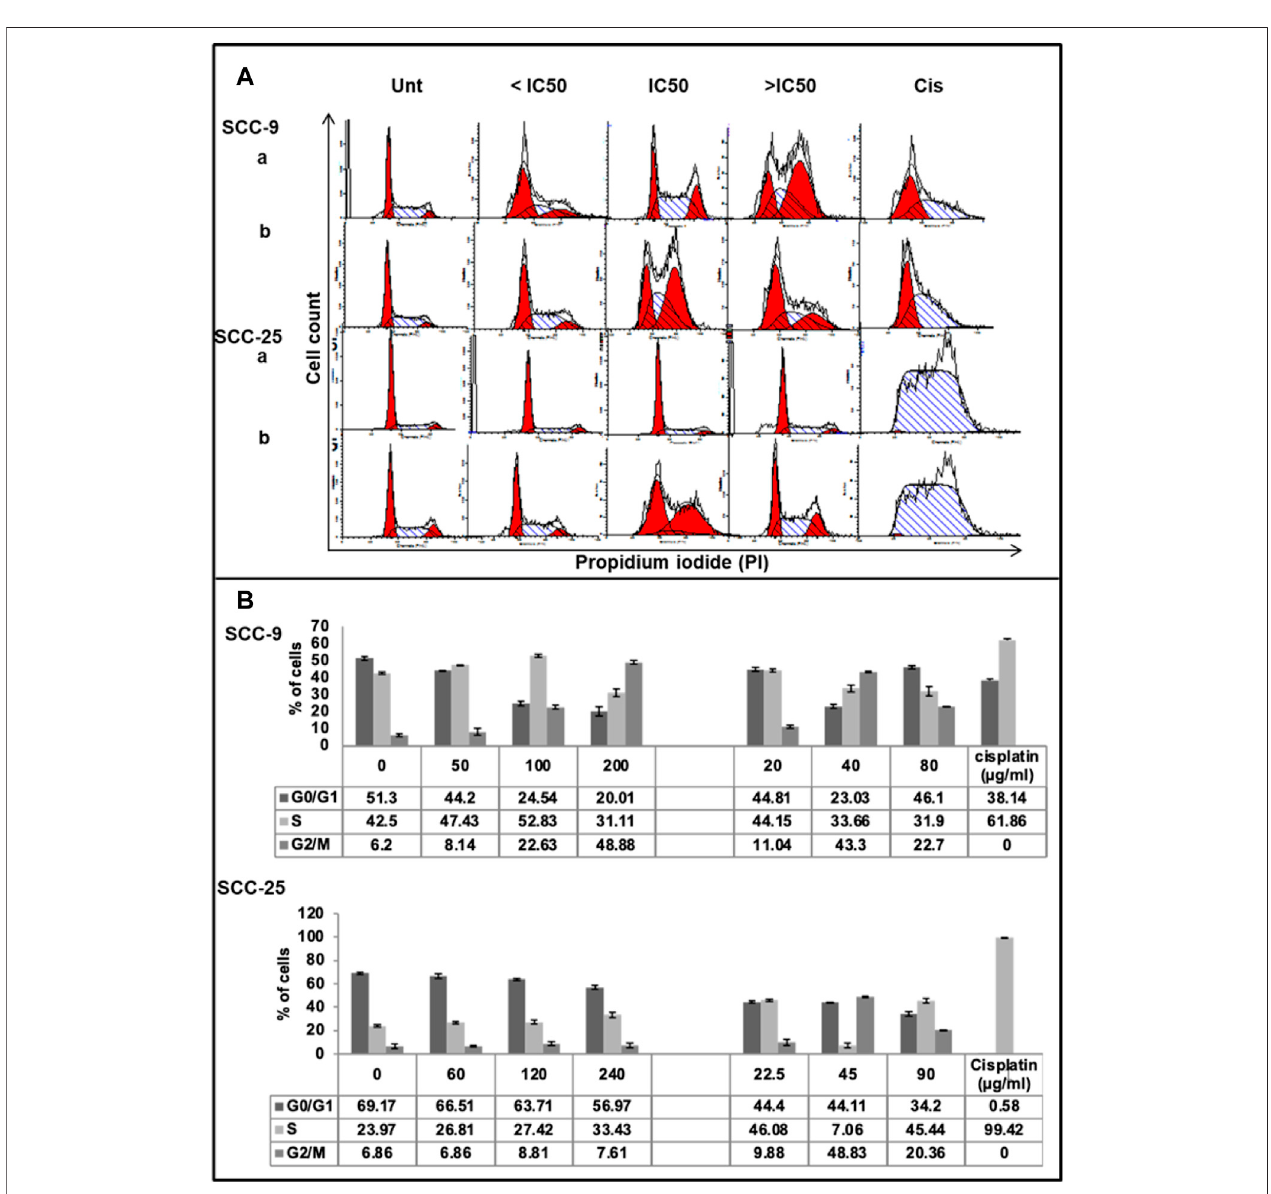
FIGURE4| EffectofCZEandCINoncellcycleoforalcancercells.FlowcytometricanalysisofDNAcontentindifferentphasesofthecellcycleafter48 hexposure to the indicated concentrations of (a) . CZE and (b) . CIN on both SCC-9 and SCC-25 cells (A) Representative histogram cell cycle analysis of untreated, CZE (50, 100, and 200 μ g/ml) and CIN treatments (20, 40, and 80 μ m) and cisplatin (2 μ g/ml) treated cancer cells (B) Bar graphs showing the percentage (each value represents as mean ± SD) of cells in each phase indicating a signi fi cant arrest in speci fi c phase of cell cycle.